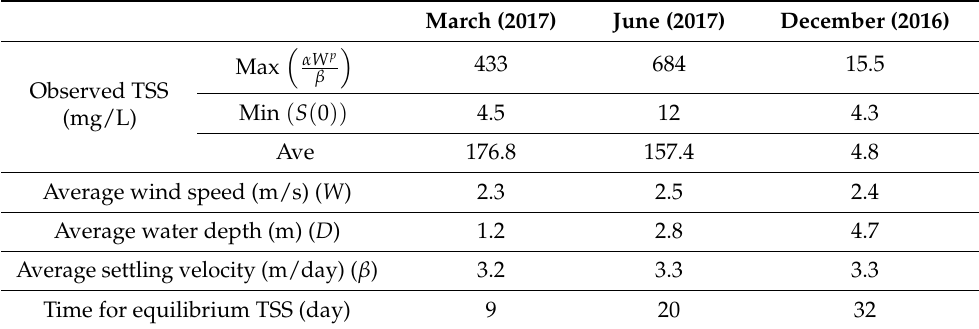
Table 6. Calculation of time to reach equilibrium TSS in Tonle Sap Lake,